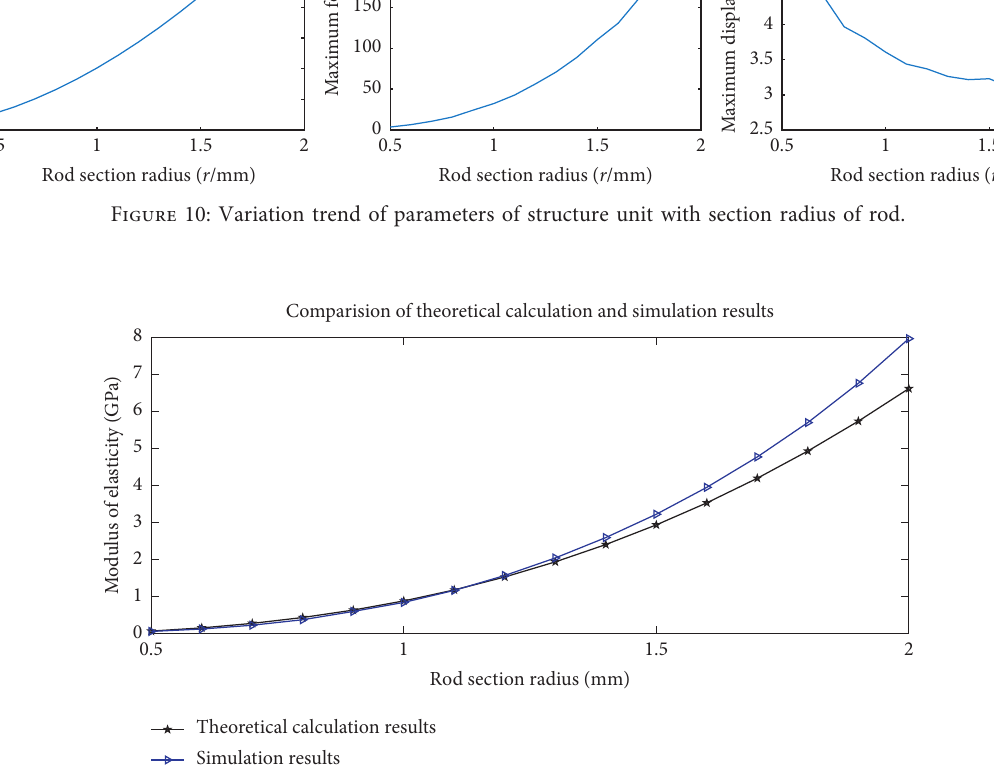
Figure 11: Comparison of theoretical and simulation results of equivalent modulus of elasticity.